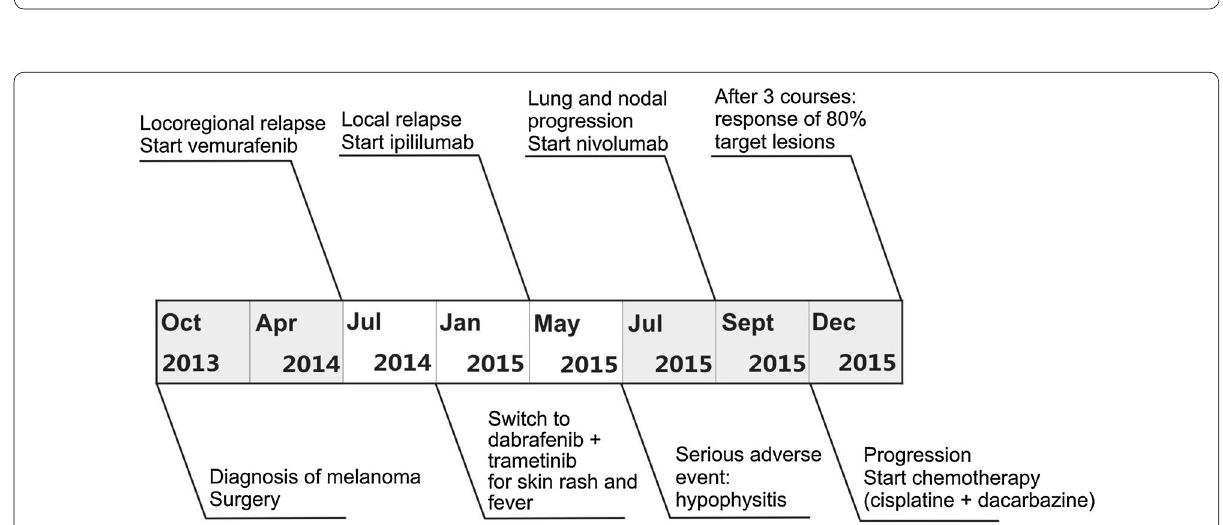
Fig. 2 Flow chart summarizing the treatment provided to this